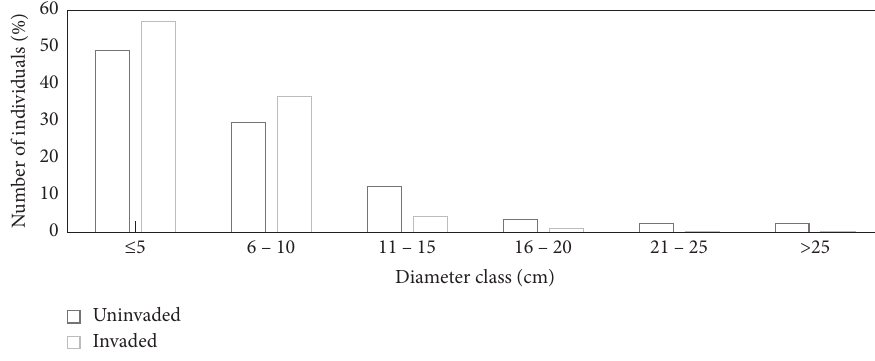
Figure 3: Diameter class distribution of woody species at both vegetation